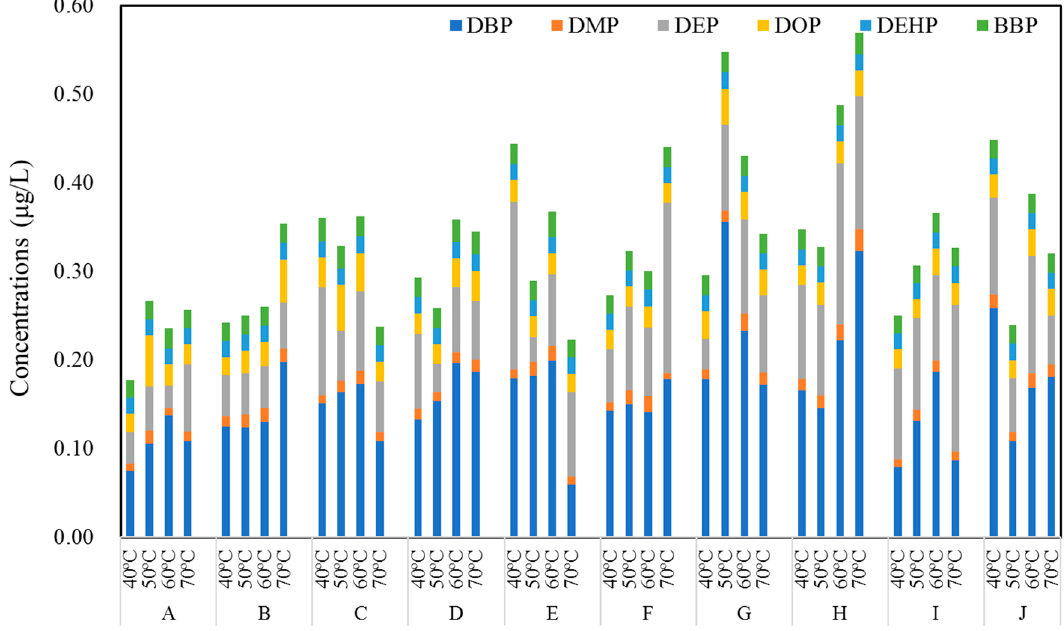
Figure 3. Total concentrations ( μ g/L) of PAEs in each brand of PET bottled water from a local supermarket after incubation at 40, 50, 60 and 70 °C for 24 h (n = 3).